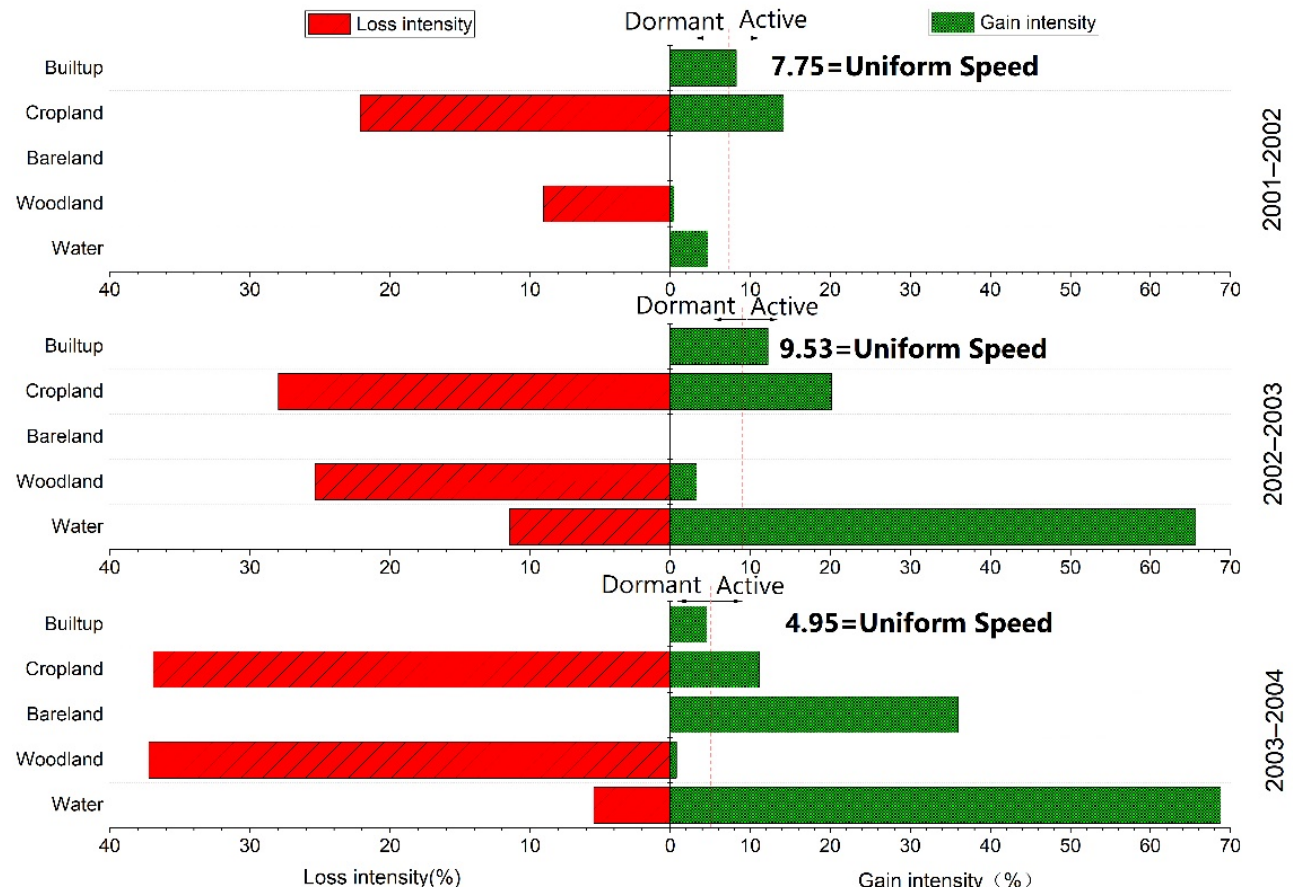
Figure 7. Category-level intensity analysis for the three time intervals.